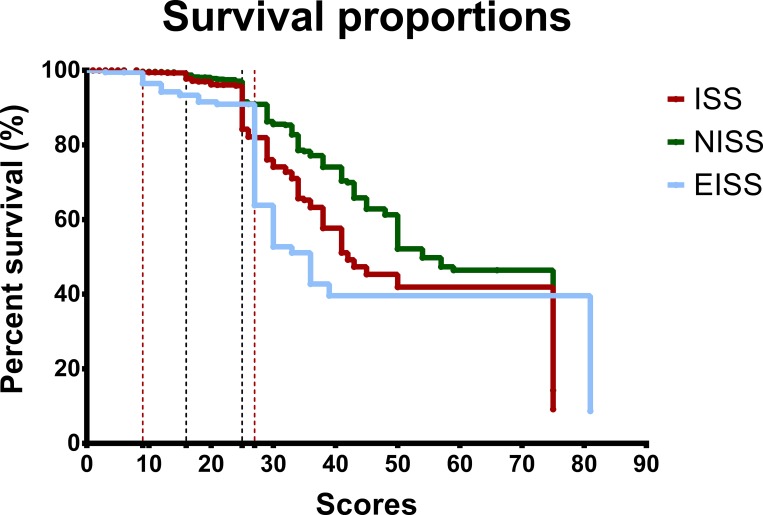
The survival rate-to-severity score relationships of all patients classified according to the ISS, NISS, and EISS.